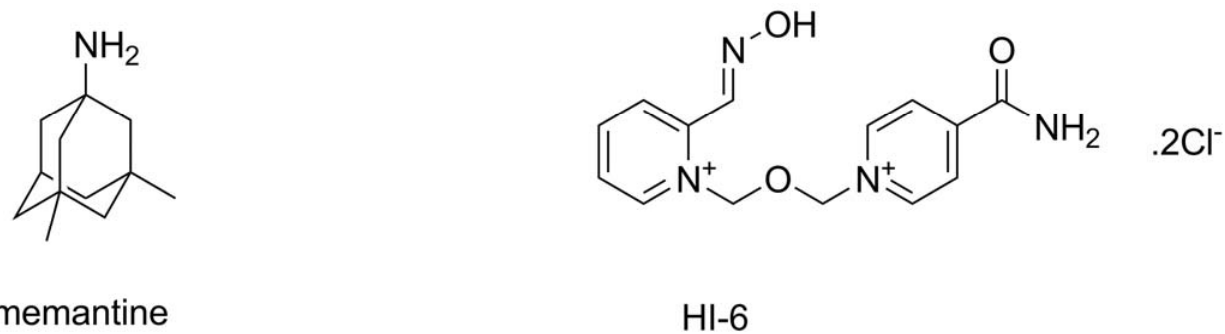
Figure 3. Structures of memantine and